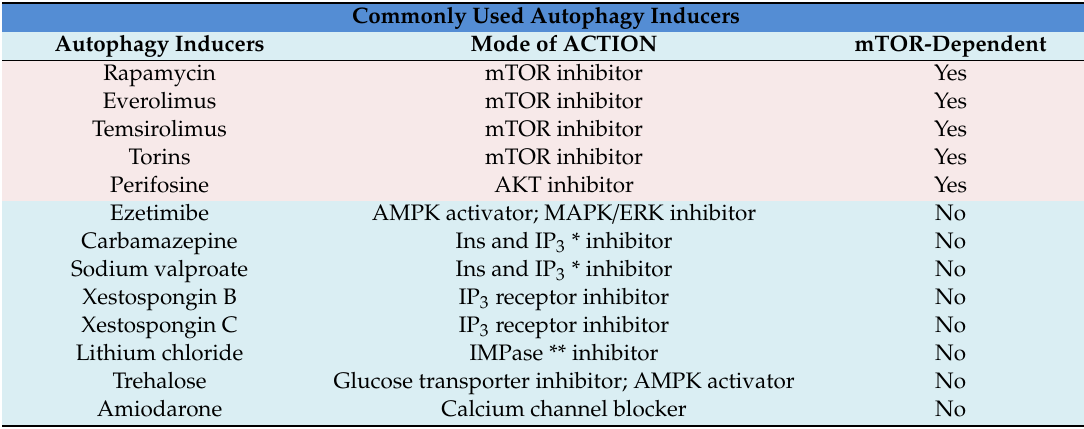
Table 2. Common autophagy inducer and their mechanism of action